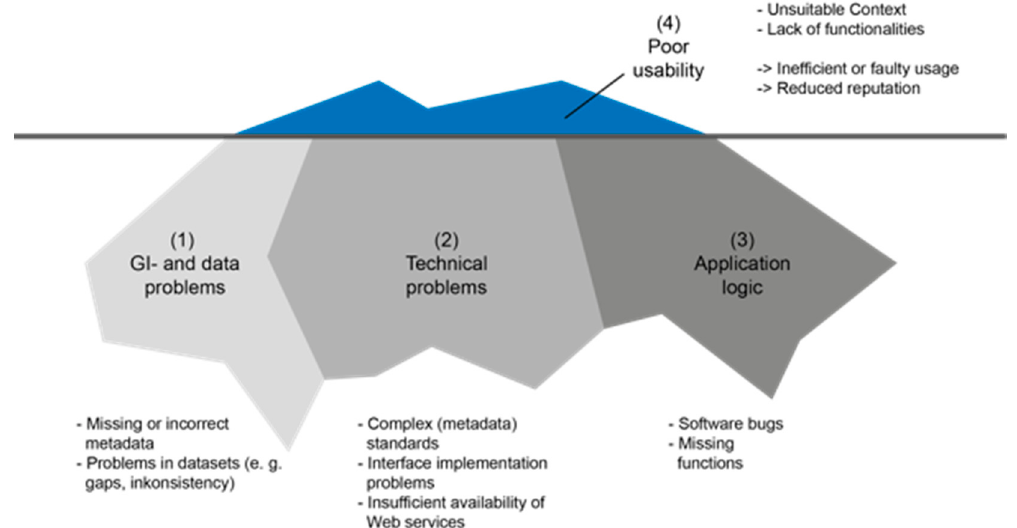
Figure 1. Aspects of usability in geoinformation (GI) web applications.